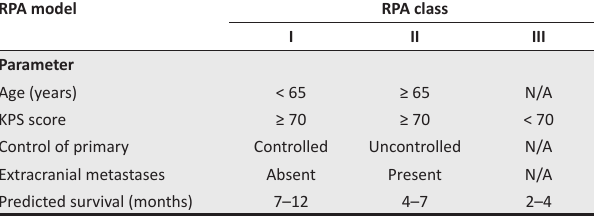
TABLE 1: Definition of prognostic classes of the Recursive Partitioning Analysis. RPA